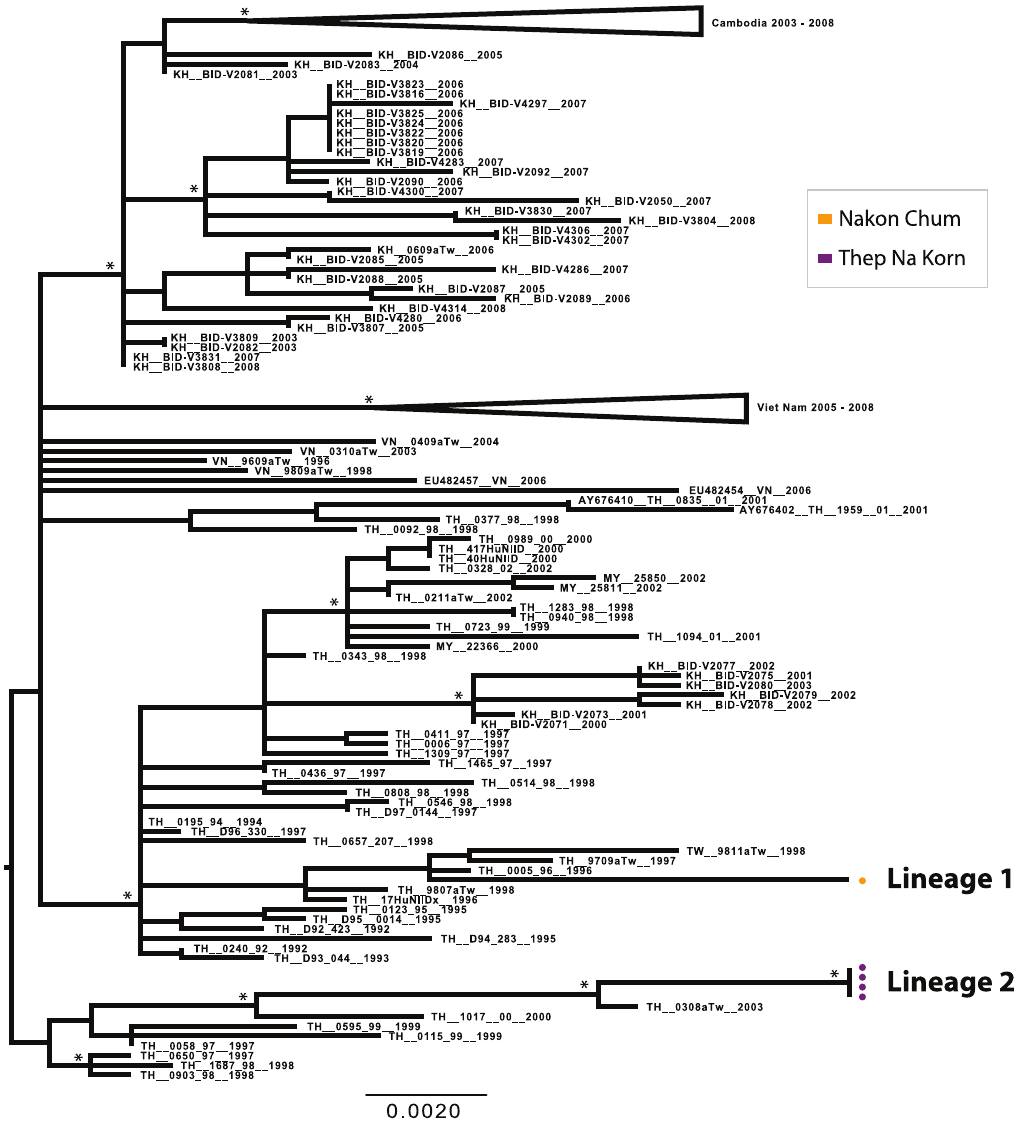
Figure 6. ML tree of representative E gene sequences of DENV-3 genotype II. Districts of Kamphaeng Phet are designated by color (Kon Tee, blue; Na Bo Kham, green; Nakon Chum, orange; Nong Pling, red; Thep Na Korn, purple). Bootstrap support values $ 85% are indicated by an asterisk next to the node. The tree is midpoint rooted for purposes of clarity.